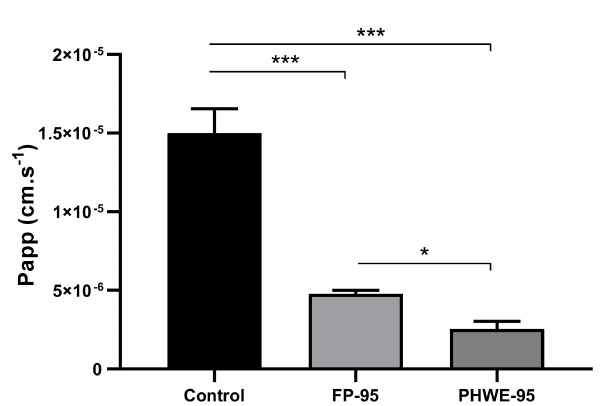
Figure 2. Glucose permeability coefficient (cm.s − 1 ) in the presence of a FP-95 (0.26 mg.mL − 1 ) or PHWE-95 (10 mg.mL − 1 ). In all samples glucose was added to the apical side at 25 mM glucose in order to simulate fed state and basolateral side was filled with Hanks glucose-free buffer. Results are presented as the mean ± standard error of the mean (SEM) ( n = 8). Significative differences versus control samples *** p < 0.001; significative difference between FP-95 and PHWE-95 * p <